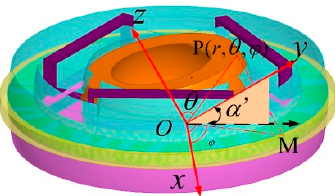
Figure 6. Coordinate systems and rotor deflection diagrams.